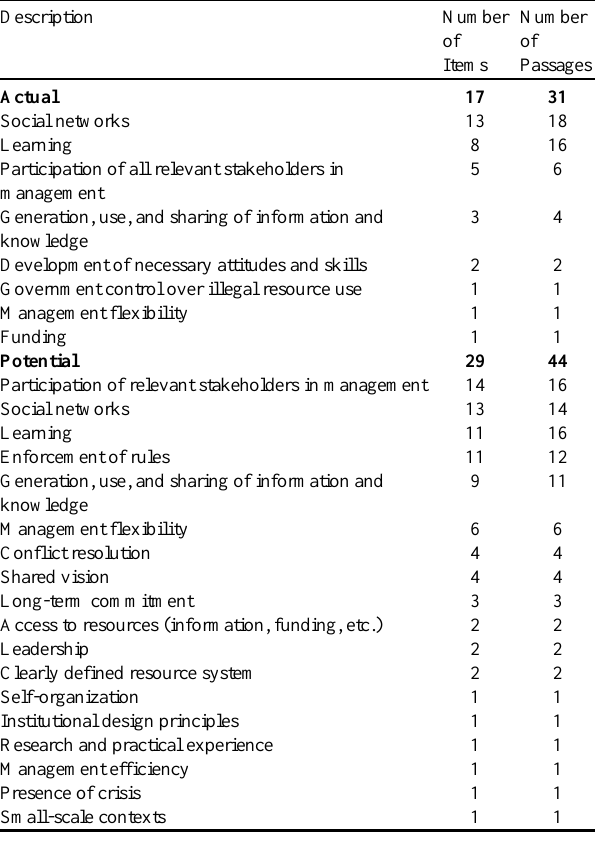
Table 7. Factors contributing to success of adaptive comanagement